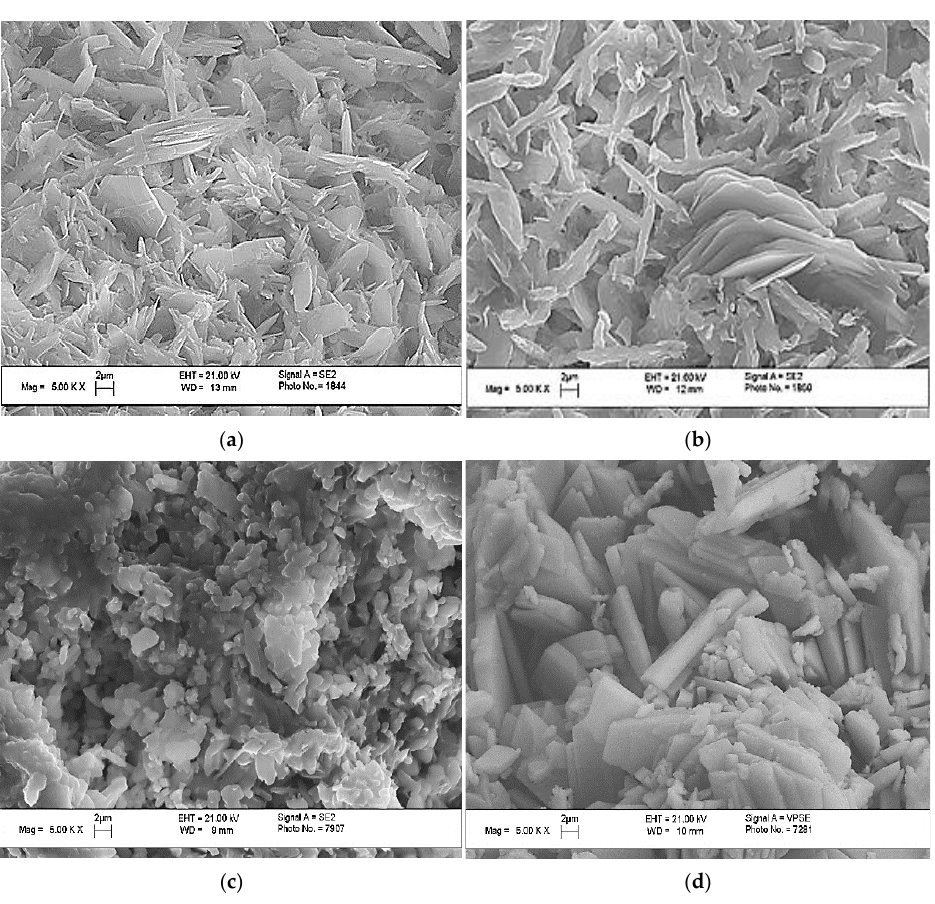
Figure 4. The SEM images of the cement stone, with a weight ratio of: ( a ) Ca(PO 3 ) 2 /Ca 2 P 2 O 7 = 0/100; ( b ) Ca(PO 3 ) 2 /Ca 2 P 2 O 7 = 5/95; ( c ) Ca(PO 3 ) 2 /Ca 2 P 2 O 7 = 10/90; ( d ) Ca(PO 3 ) 2 /Ca 2 P 2 O 7 = 20/80.